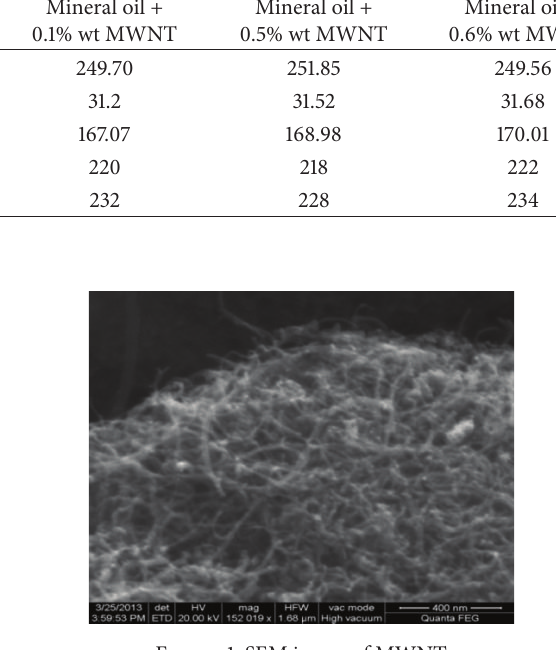
Figure 1: SEM image of